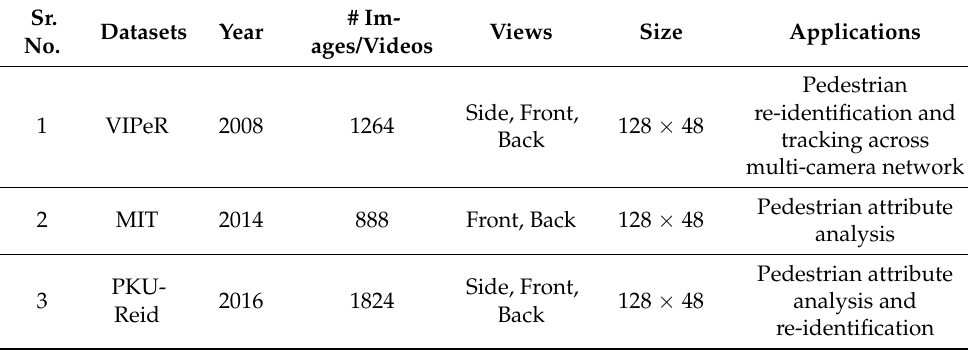
Table 2. Statistics of testing datasets for PGC.